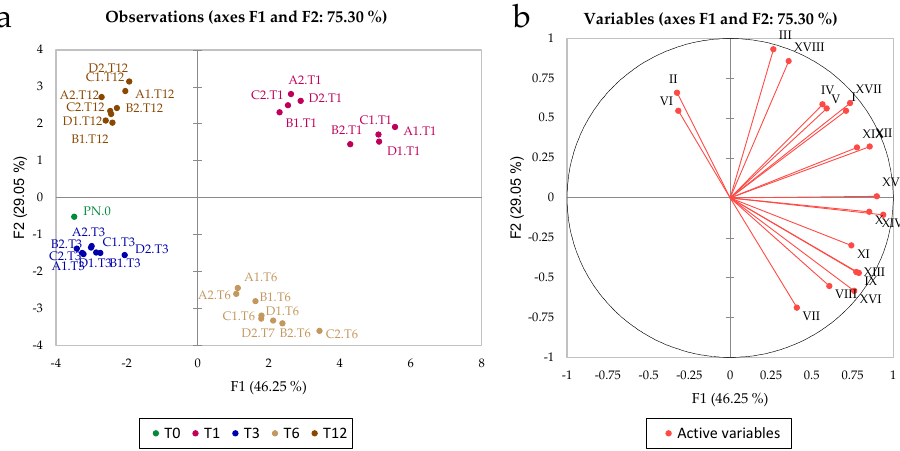
Figure 3. Observations and variables graph from GC × GC-TOF/MS data. T0, T1, T3, T6, and T12 indicate the storage months (0, 1, 3, 6, 12) at which the samples were analysed. A, B, C, and D indicate the treatment (see Figure 1 for details). ( a ) Scores plot, ( b ) Loadings plot.